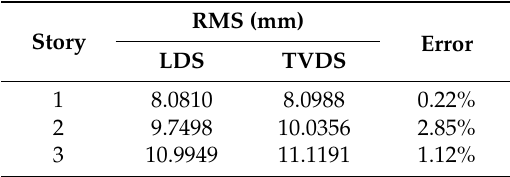
Table 2. Displacement data reliability results on the scaled-model excitation